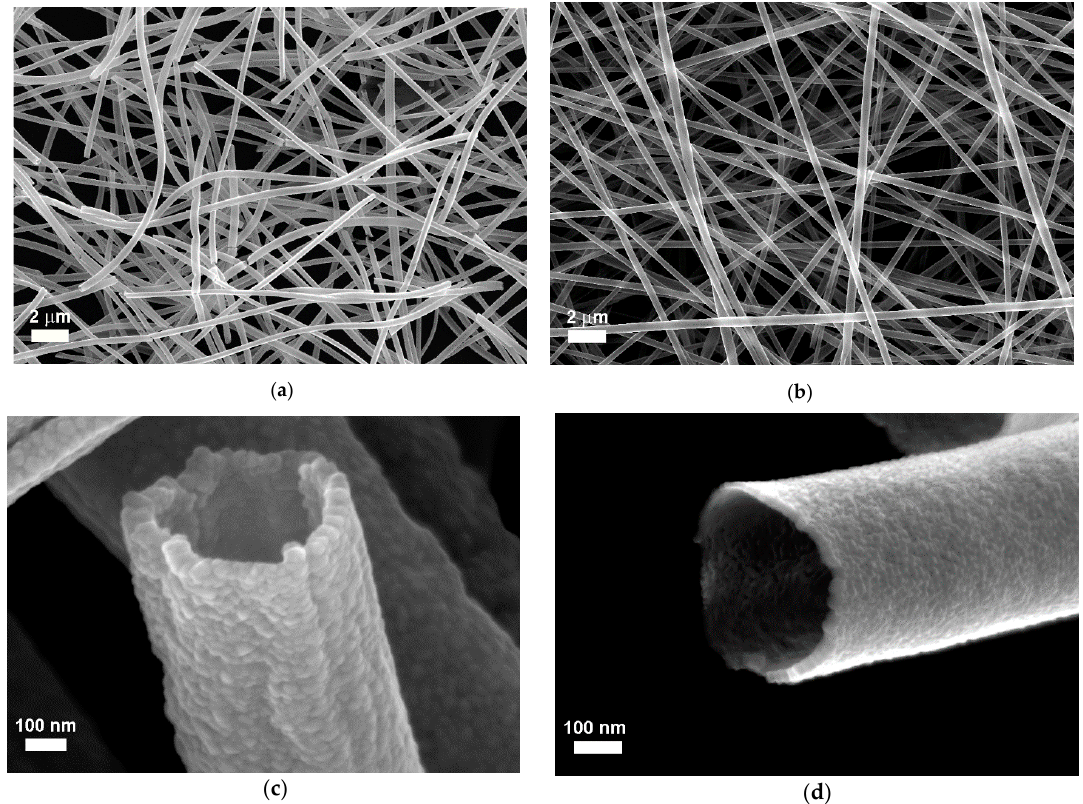
Figure 2. FESEM images of ZnO nanotubes ( a , c ) and TiO 2 nanotubes ( b , d ) at different magnifications.